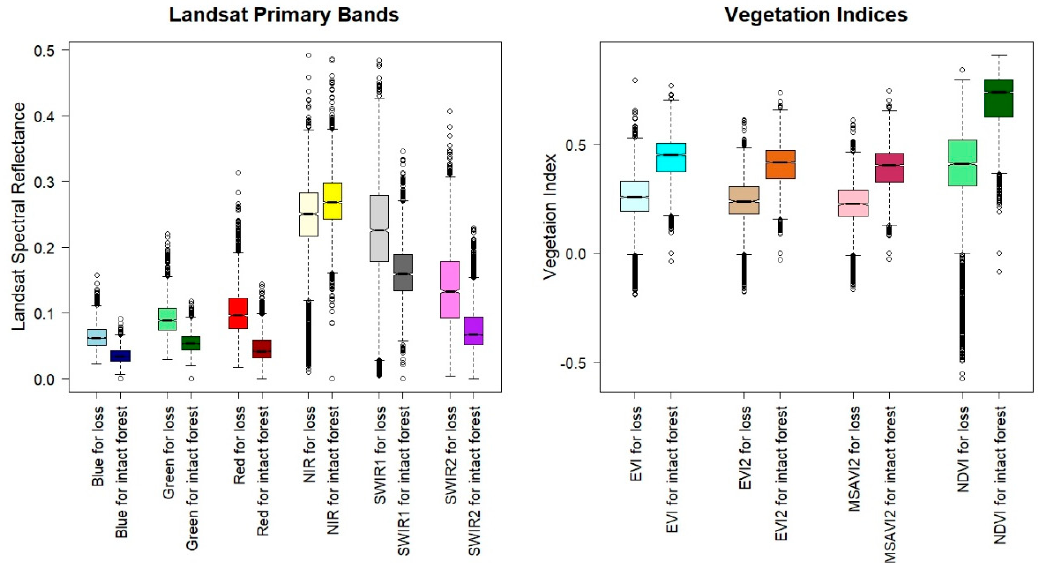
Figure A1. Box plots showing the Landsat spectral bands and vegetation indices used for deforestation mapping for both forest loss and non-loss validation points using random forest as the classifier.